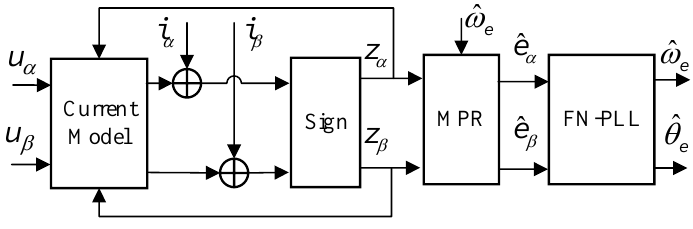
Figure 11. Block diagram of improved rotor position observer.